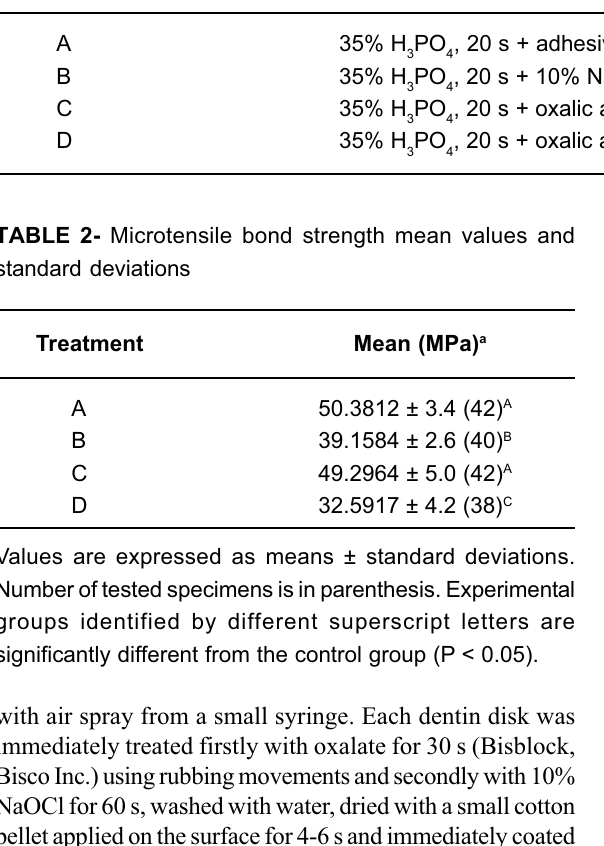
TABLE 1- Dentin treatments used in this study